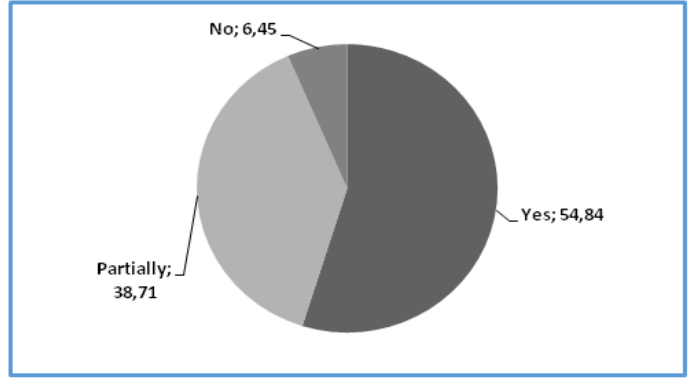
Fig. 1. Percentages of responses regarding the control and correction of learner errors